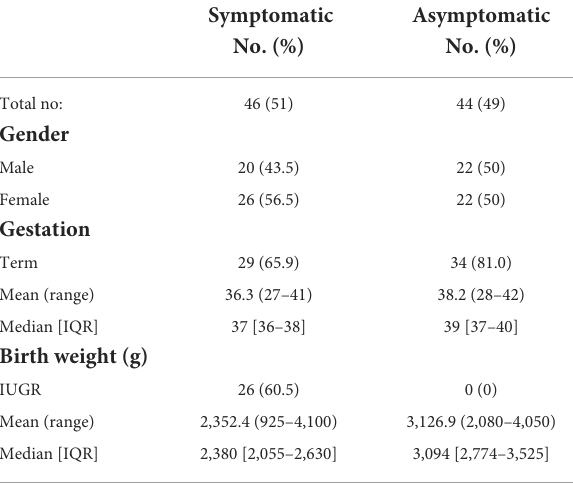
TABLE 1 Demographics of infants with cCMV in this